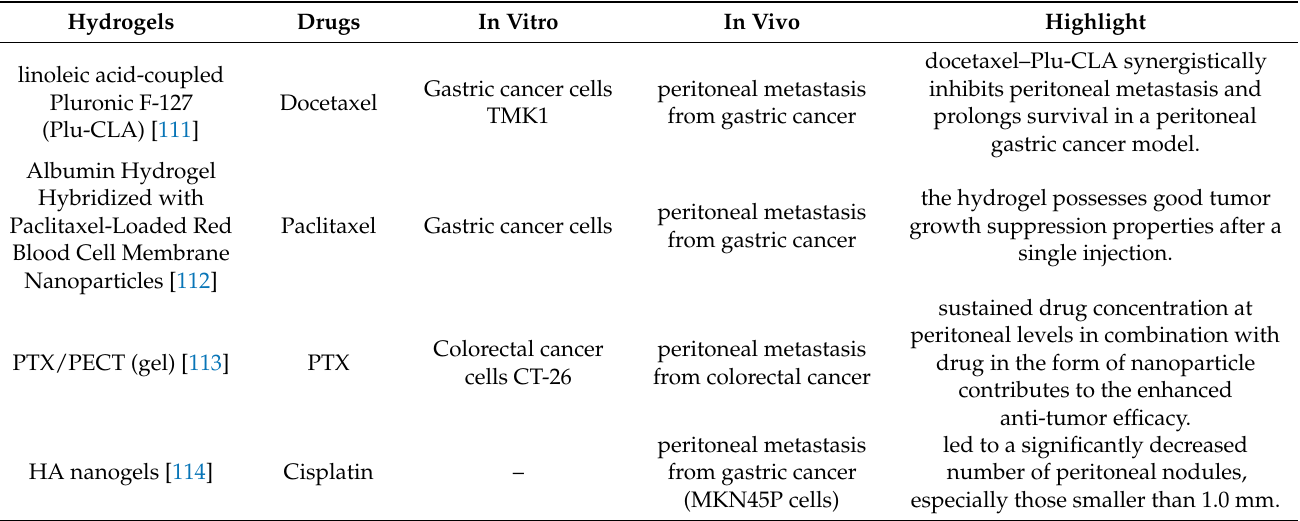
Table 2. New delivery systems using hydrogels as a carrier for the treatment of peritoneal carcino- matosis from different